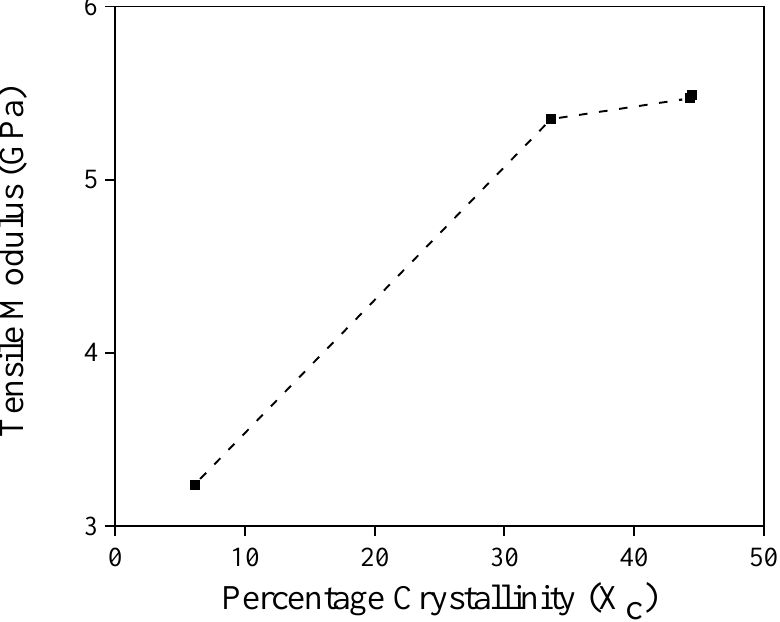
Figure 6. Tensile modulus of the NF-reinforced PLA composites with different NA contents as a function of percentage crystallinity.